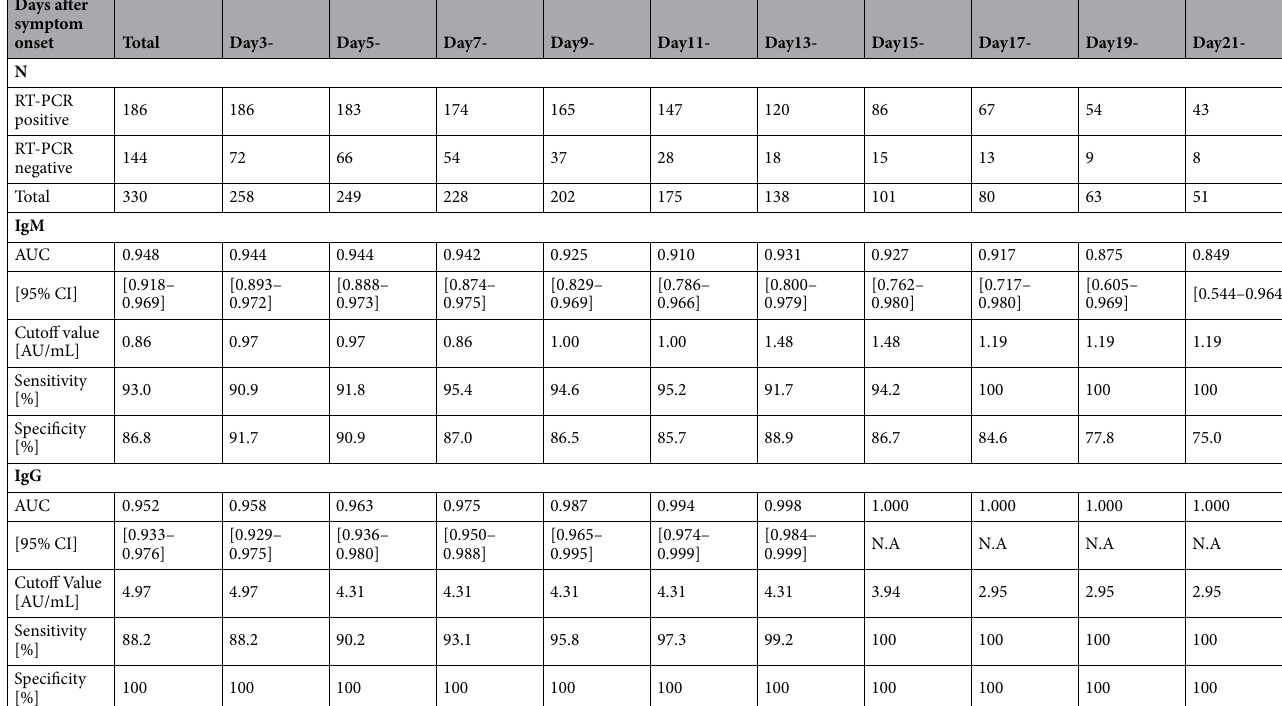
Table 1. The time course of the diagnostic values determined with ROC